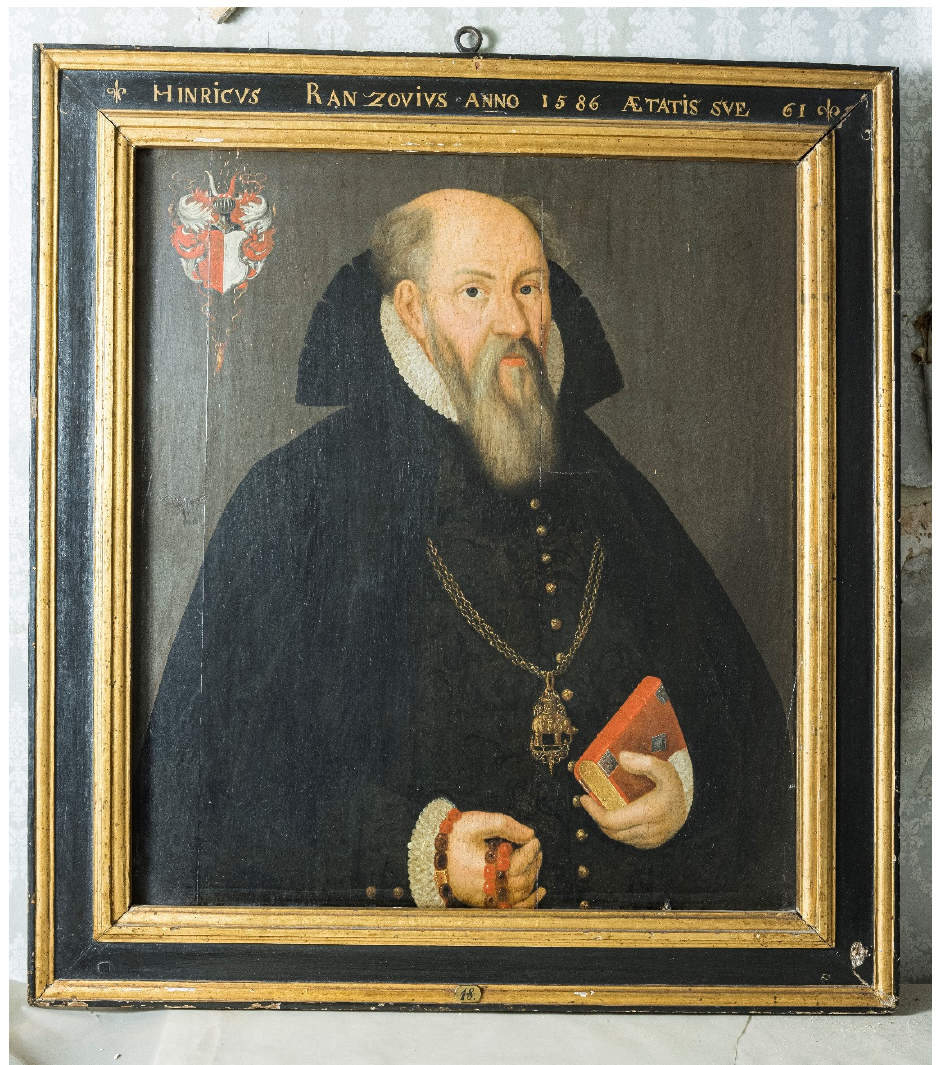
Figure 5. The learned Lutheran nobleman Henrik Rantzow (1526–96) clutching his rosary. Portrait in the church of Brahetrolleborg on the island of Funen. Photo: Arnold Mikkelsen, The Danish National Museum.